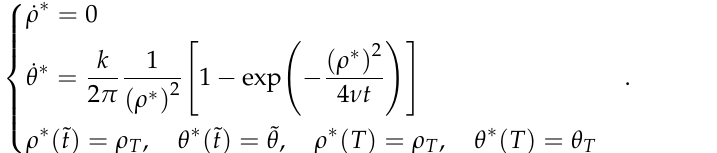
Figure 1, we set ˜ t = 70 s and varied C θ . The large dashed circumferences correspond to √ √ circular trajectories of radius 2 m and 2 2 m, the open circles identify the specified initial and final points for the problem, and the red curve represents the trajectory of the particle corresponding to the second regime of motion. The blue and pink lines represent two possible trajectories for the particle in the first regime of motion, corresponding to different values for C θ . The black dots correspond to a variety of possible initial positions for the simulation, each for a different C θ . We note that the radial coordinate of the initial position increases with C θ and that changing this parameter alone is not sufficient to retrieve the desired initial position. Therefore, ˜ θ must play a role in